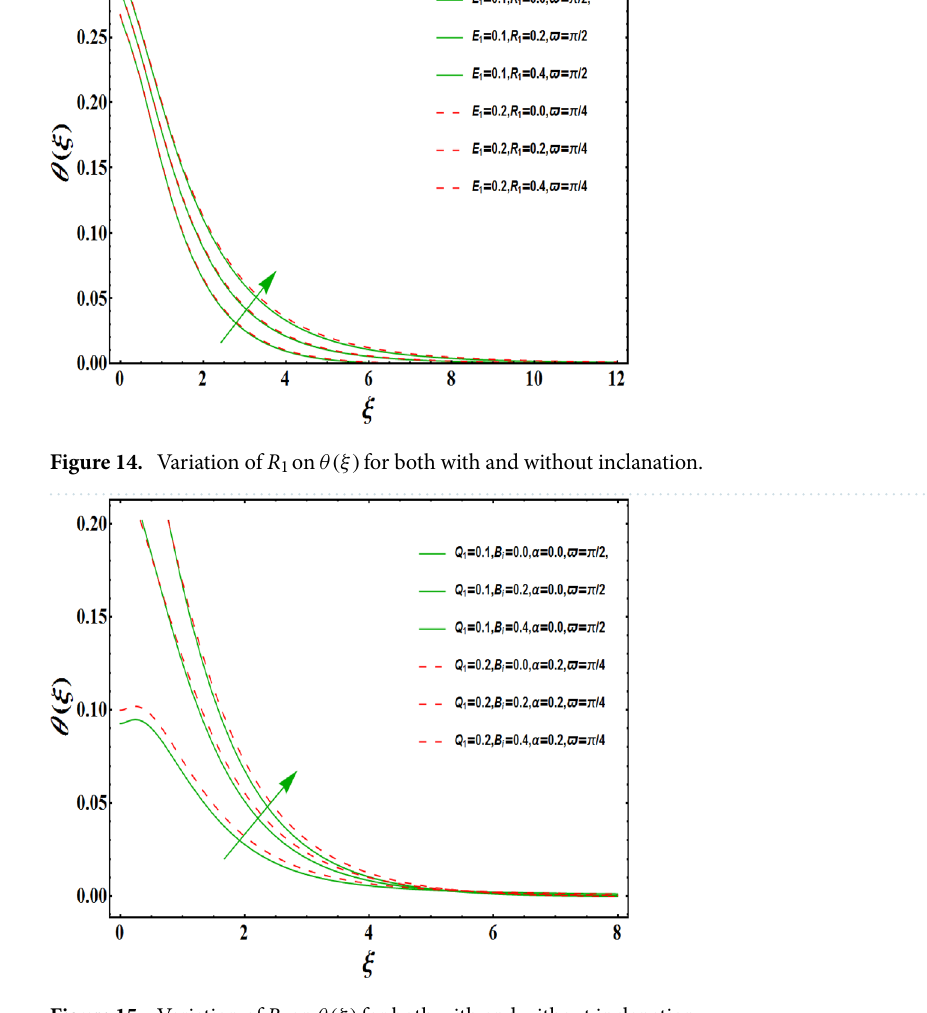
Figure 15. Variation of B i on θ(ξ) for both with and without